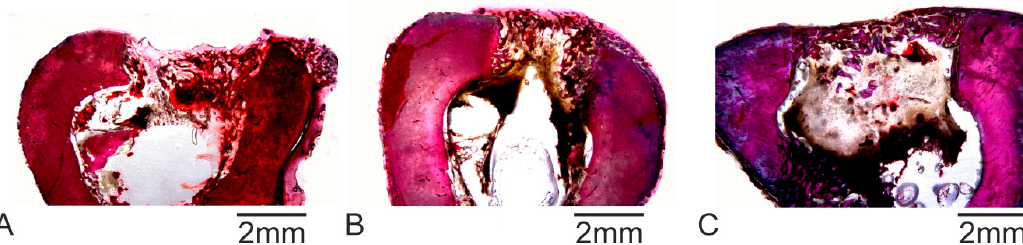
Figure 4. Histological analysis of the control group. In ( A ), samples at 15 days after placement of the critical defects, the samples showed an intensive granulation reaction area; in ( B ), samples at 30 days, where the bone defect began to be filled by the bone matrix from the border of the lesion; and, in ( C ), 60 days after injury, the defect was closed but the new bone formed was of poor quality, mainly in the center of the defect.